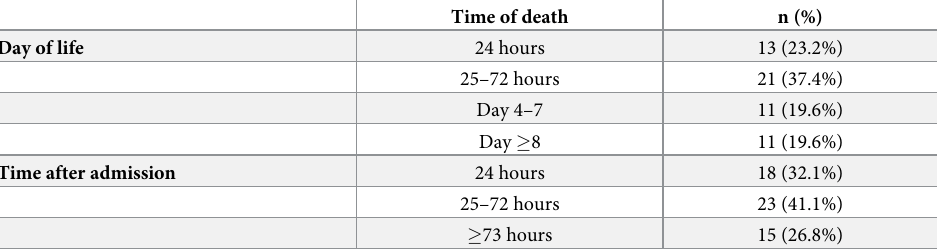
Table 2. Time of death of deceased newborns in relation to their day of life respectively the time after admission at